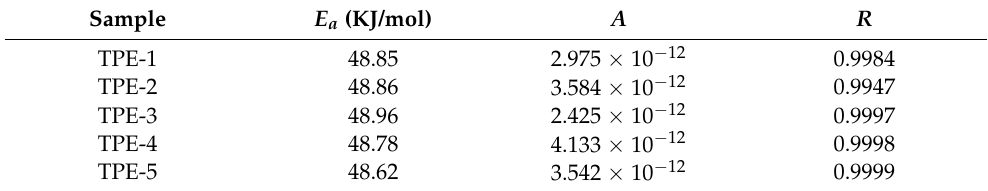
Table 2. The calculating parameters of TPEs (the results are obtained according to Equation (11)).